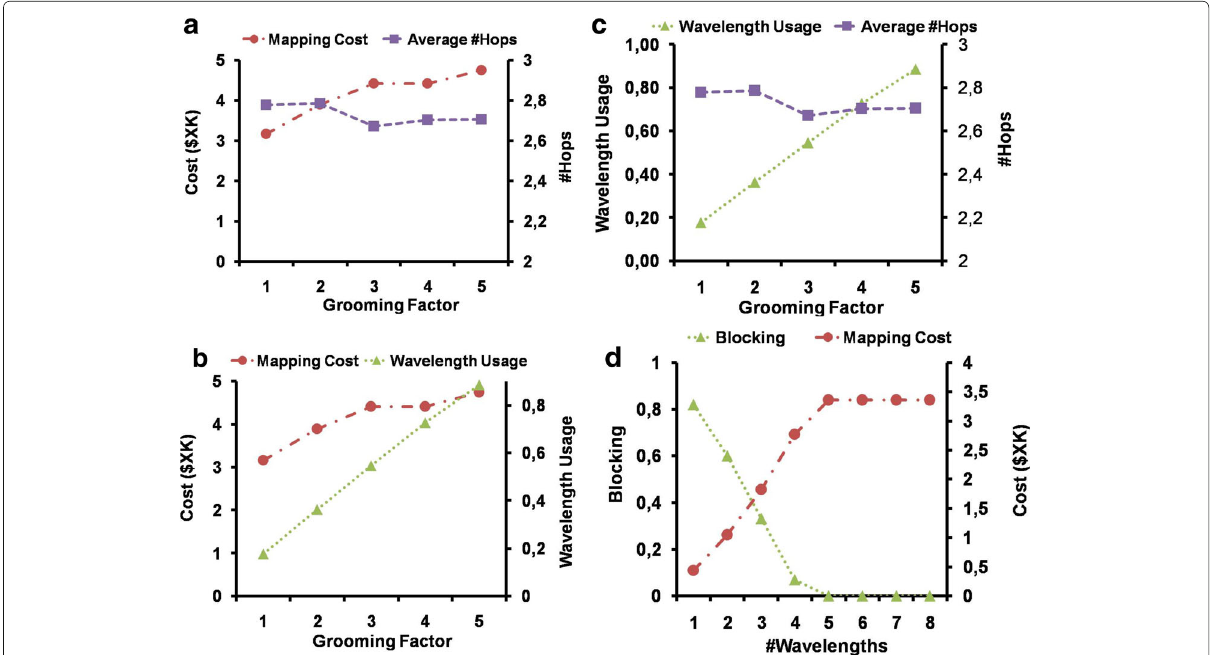
Fig. 7 Impact of Grooming factor. a Mapping cost and Number of hops. b Wavelength use and mapping cost. c Wavelength use and Number of hops. d Blocking and mapping